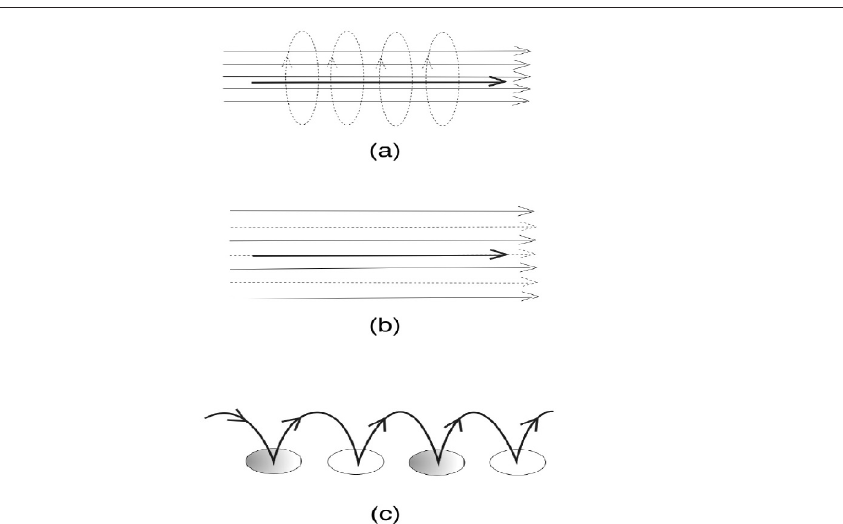
Figure 2. A sketch of di ff erent gauge configurations and localizations of chiral zero modes of quarks [16] (a) color electric flux-tube; (b) collinear color- electric and magnetic flux-tube; (c) a flowline in the instanton liquid [14] where quarks travel by hopping on the instantons and the anti-instantons. The solid thick lines represent the motion of the quarks. The thin solid lines and dotted lines represent color electric and magnetic fields respectively. The grey circles and white circles are instantons and anti-instantons